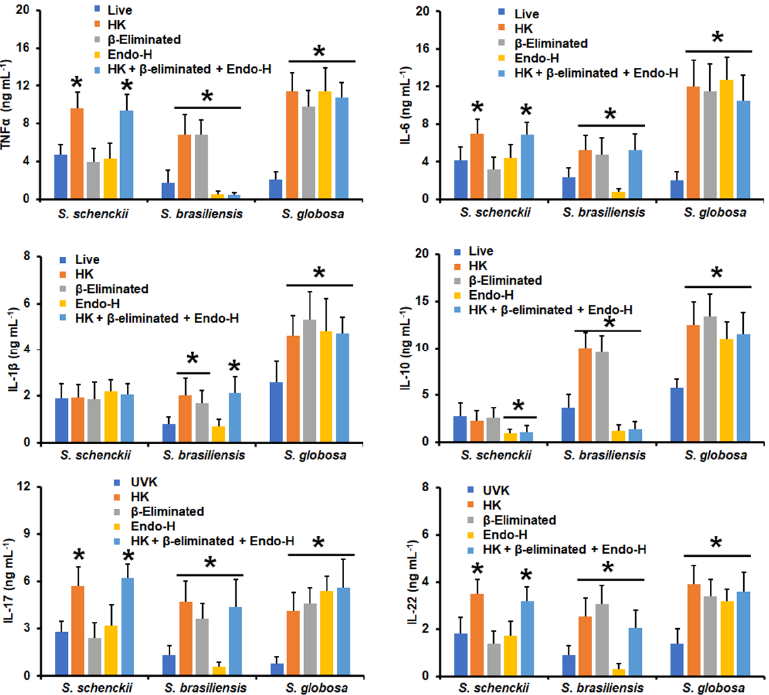
Figure 4. Cytokine production by human peripheral blood mononuclear cells stimulated with yeast- like cells from Sporothrix schenckii , Sporothrix brasiliensis , or Sporothrix globosa . For tumor necrosis factor-alpha (TNF α ), interleukin 1 β (IL-1 β ), interleukin 6 (IL-6), and interleukin 10 (IL-10), human peripheral blood mononuclear cells were co-incubated for 24 h with conidia previously subjected to the indicated treatments (see Materials and Methods for details). Alternatively, for interleukin 17 (IL-17) and interleukin 22 (IL-22) stimulation, the human cells were co-incubated with the UV-killed fungal cells or subjected to the indicated treatments. In all cases, the interactions were centrifuged, supernatants collected, and cytokines quanti fi ed by ELISA. UVK—UV-killed cells; HK—heat-killed cells; Endo-H—treatment with endoglycosidase H. Results are the median ± standard deviation from data generated with samples from eight donors, analyzed in duplicate. * p < 0.05 when compared with the cytokine level stimulated by live or UV-killed cells.